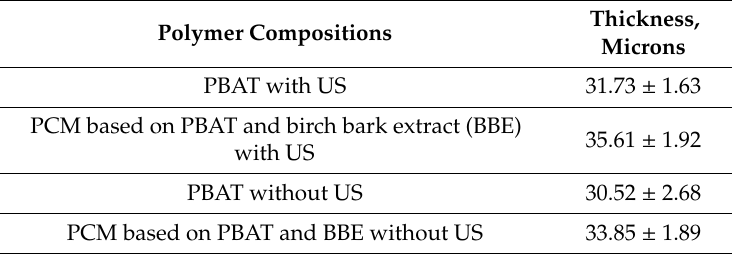
Table 3. Thickness of the obtained PCM film samples.